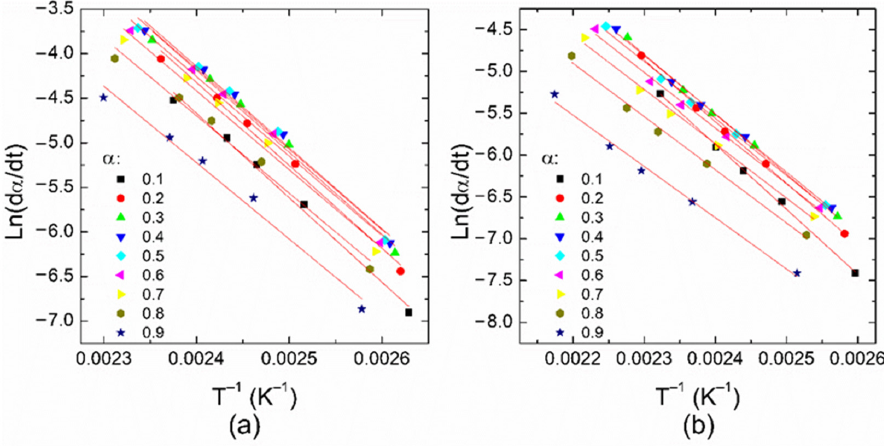
Figure 6. Friedman plots for ( a ) reaction 1 and ( b ) reaction 2 at different conversion degrees. Fitting curves are also shown as red lines.